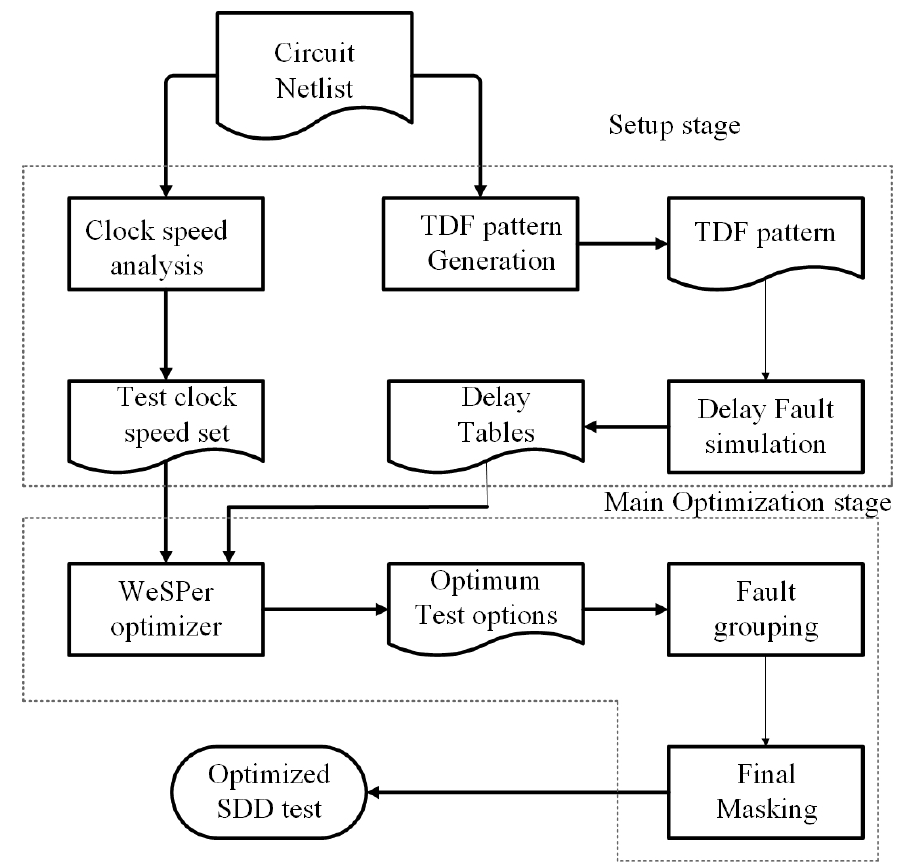
Figure 16. Flow diagram for WeSPer based pattern generation for SDDs and HDDs